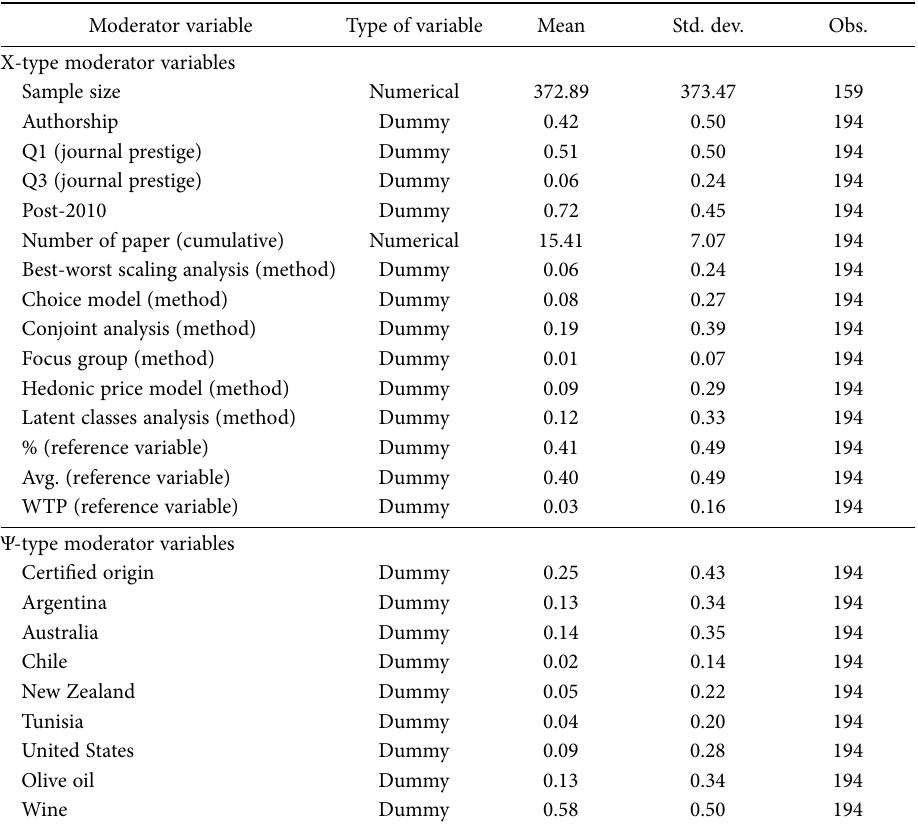
Table 3. List and description of moderator